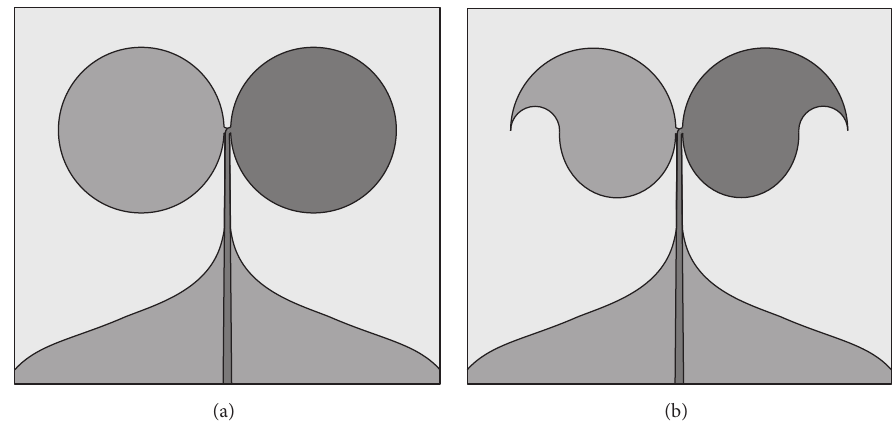
Figure 30: Geometry of the circular (a) and drop-shaped (b) antipodal dipole antenna employing an unbalanced feeding line [95]. Dark gray upper metal face, medium gray bottom metal face, and light gray dielectric substrate.